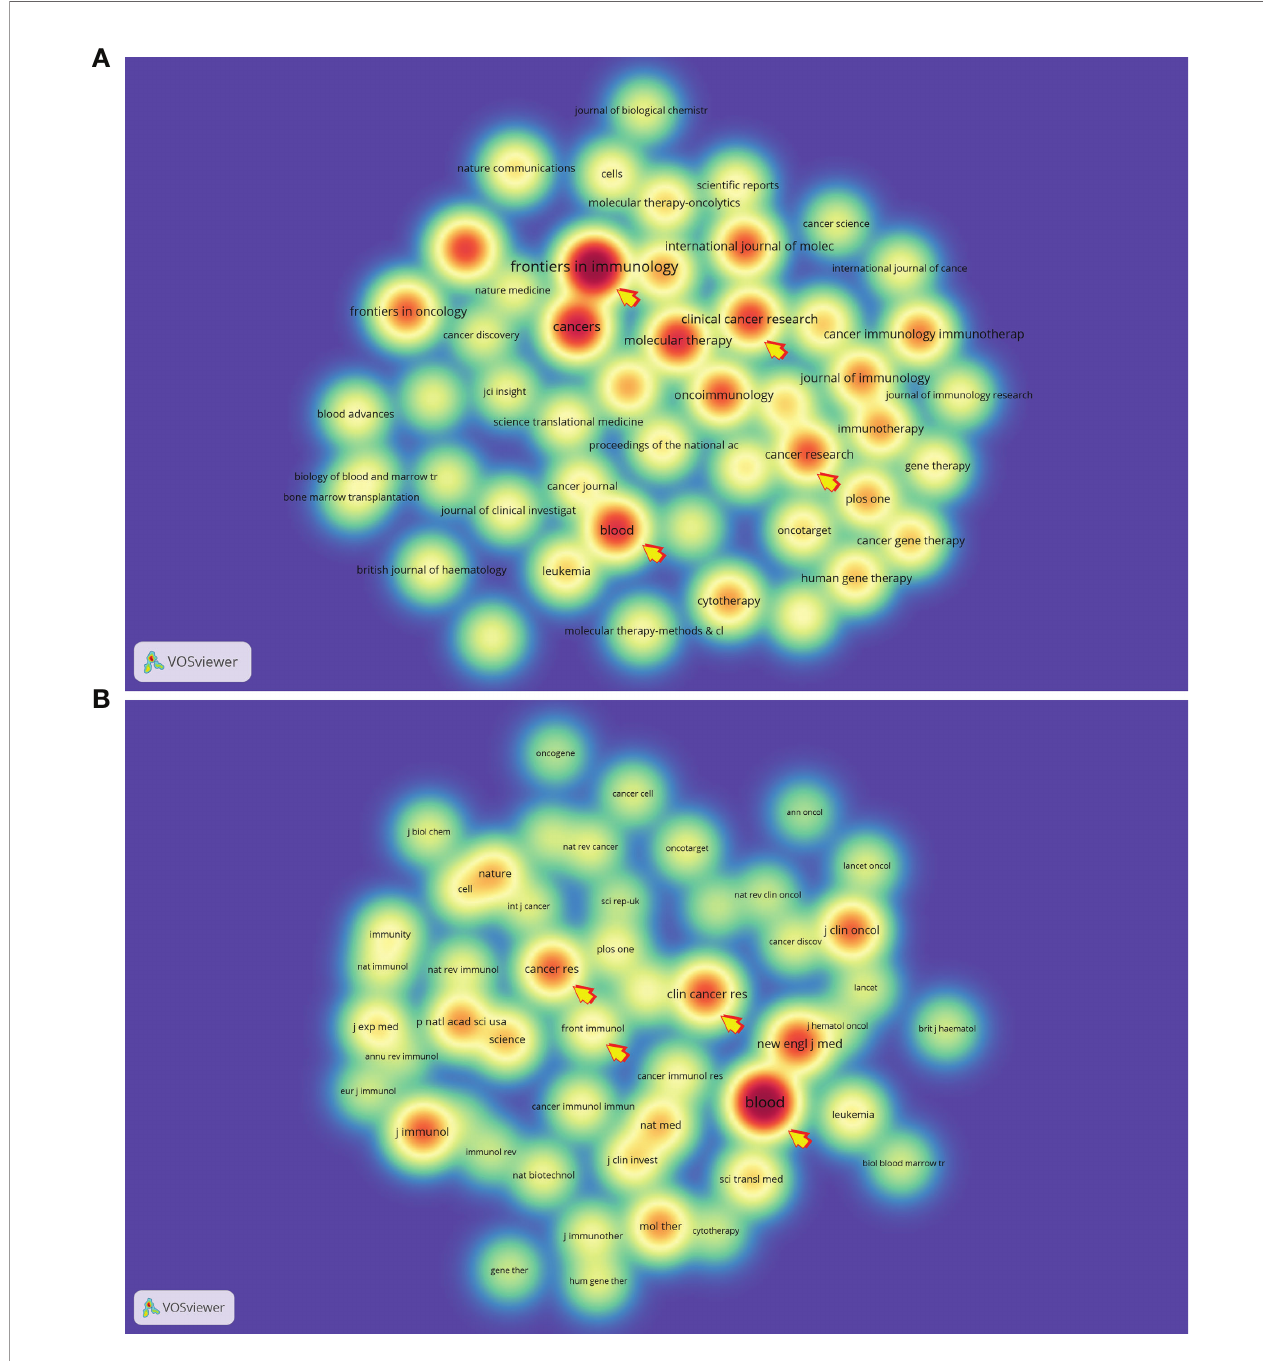
FIGURE 2 | The spectral density map of (A) citing and (B) co-cited journals. The arrows point to the journals that are present in both